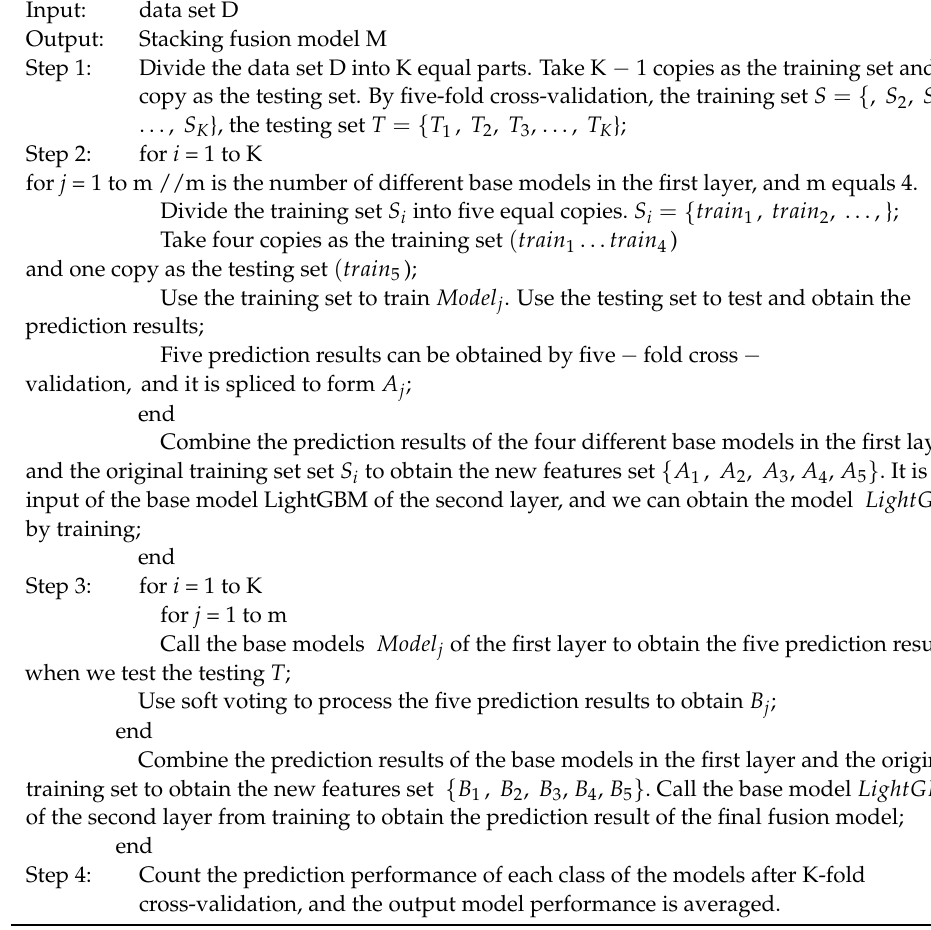
Algorithms 2. Stacking Fusion Model